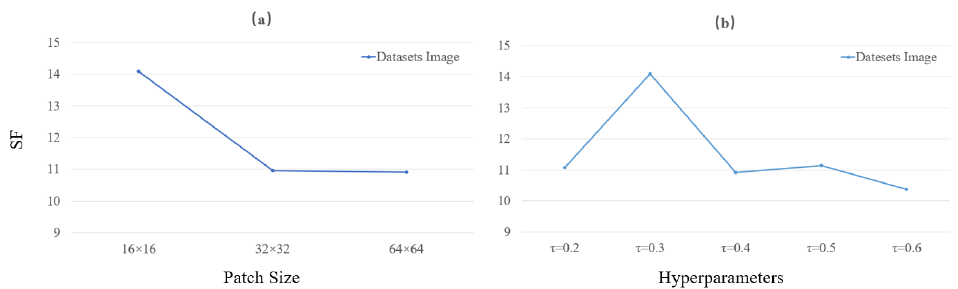
Figure 9. Performance with different parameters. ( a ) A comparison of different patches; ( b ) A comparison of different hyperparameters τ .